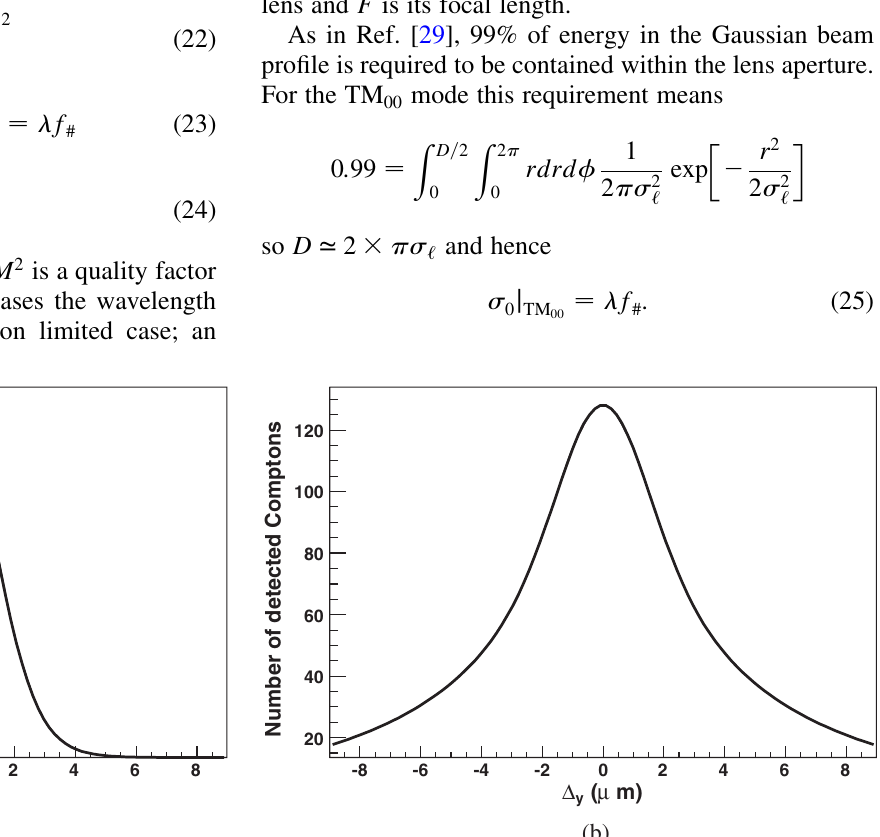
FIG. 12. Scan profile at the laser-wire IP for a laser with M 2 (cid:1) 1 : 3 and wavelength 532 nm operating in the TM optics. The electron bunch is assumed to have a Gaussian transverse profile. (a) (cid:2) using f 1